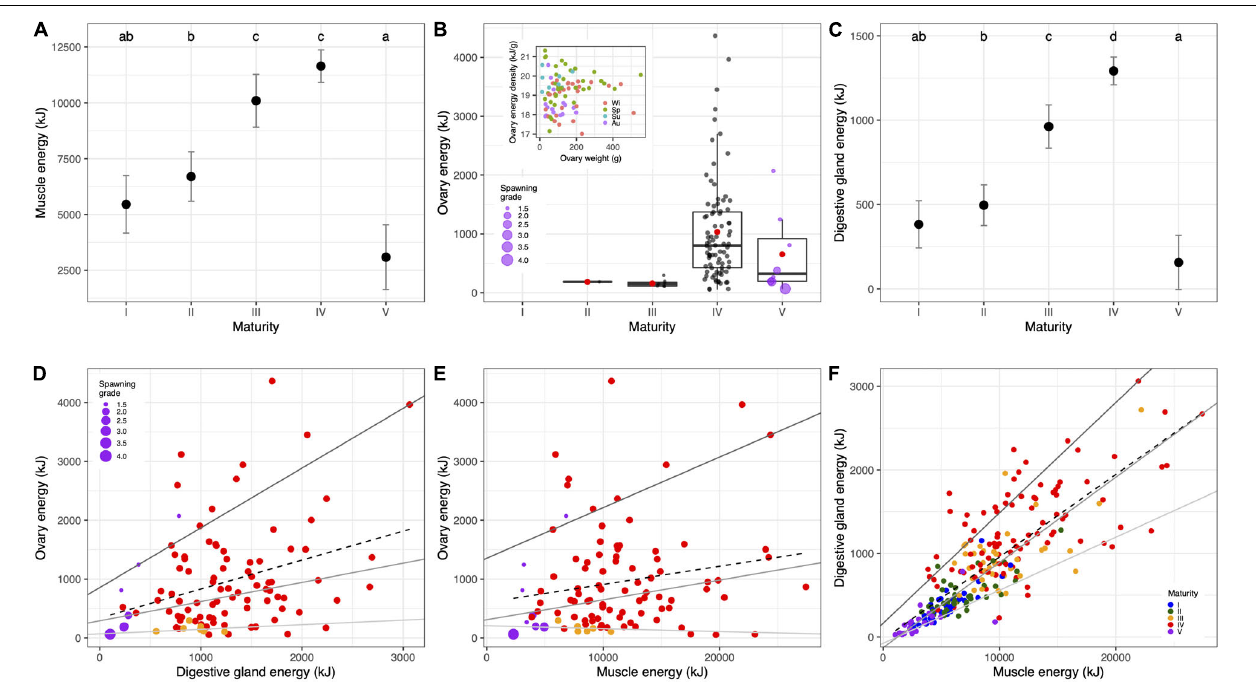
FIGURE 10 | Changes in energy across maturity stages in the muscle (A) , ovary (B) , and digestive gland (C) . The inset in (B) shows a scatterplot of the ovary weight and ovary energy density colored by season for macrostage IV females. (D–F) Show the relationships between energy content in specific tissues illustrating the energetic trade-offs. Dots are colored by maturity macrostage, and spawning and post-spawning individuals are scaled according to the spawning grade in (D,E) . Lines in (D–F) show quantile regression fits for 0.90, 0.50, 0.10 quantiles (solid lines from dark gray to light gray), and least squares regression (dashed line). See Supplementary Table 3 for numerical results, and Supplementary Figure 14 for a plot including glycogen in the energy content